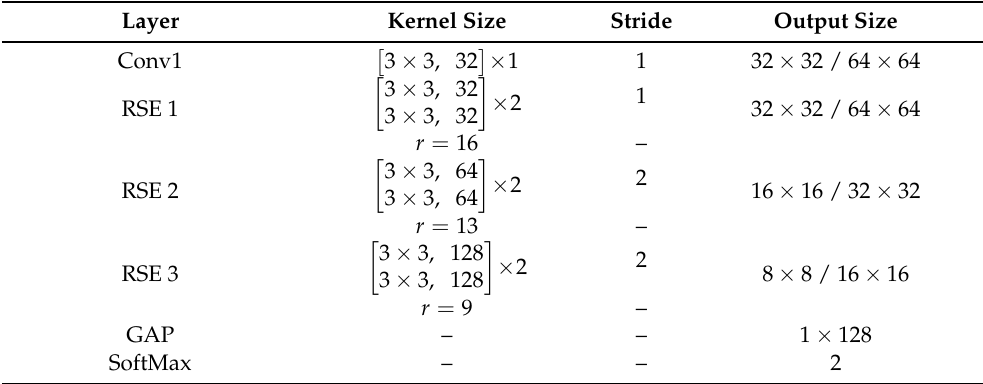
Table 1. LSRE-Net architecture. The dilation ratio r of the SE sub-module of the RSE block is specified. The input sample size is a 32 × 32 and 64 × 64 image